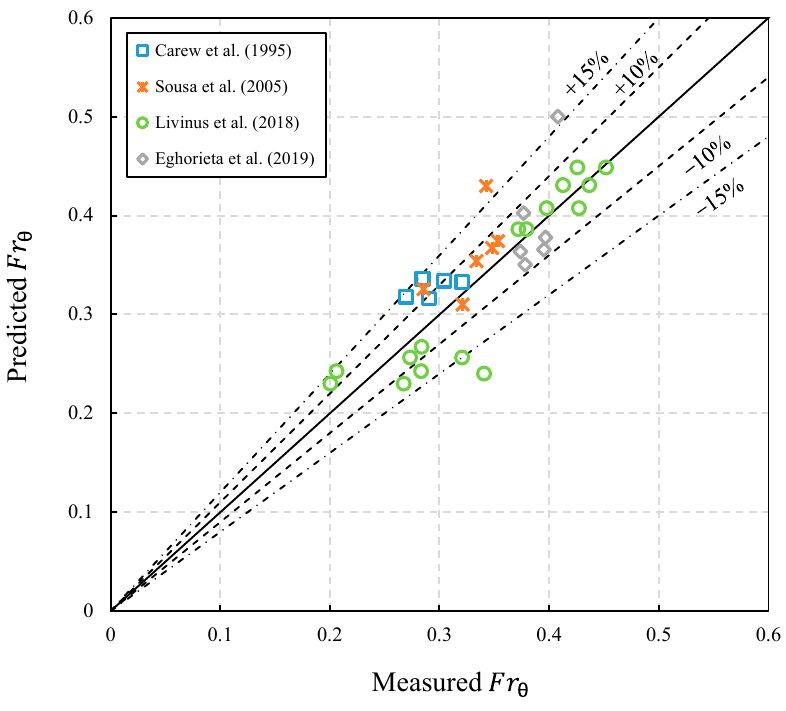
Figure 13. The performance of the proposed correlation against a database of other investigator’s results (using both Newtonian and non-Newtonian fluids).